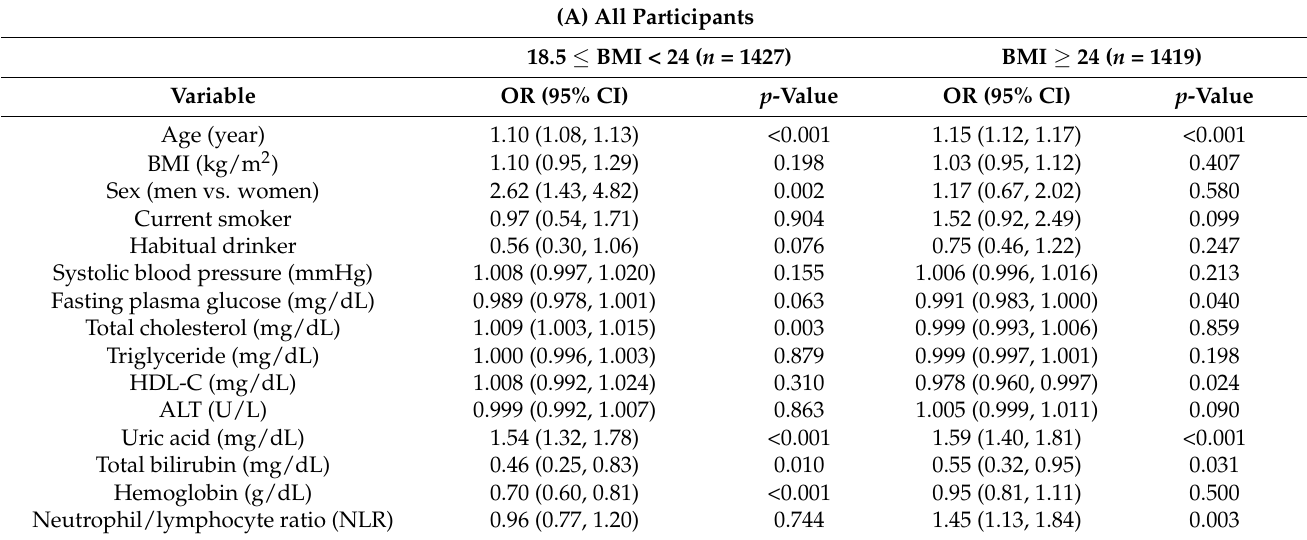
Table 4. Odds Ratios for CKD Stratified by BMI Status in All participants ( A ), Men ( B ), and Women ( C